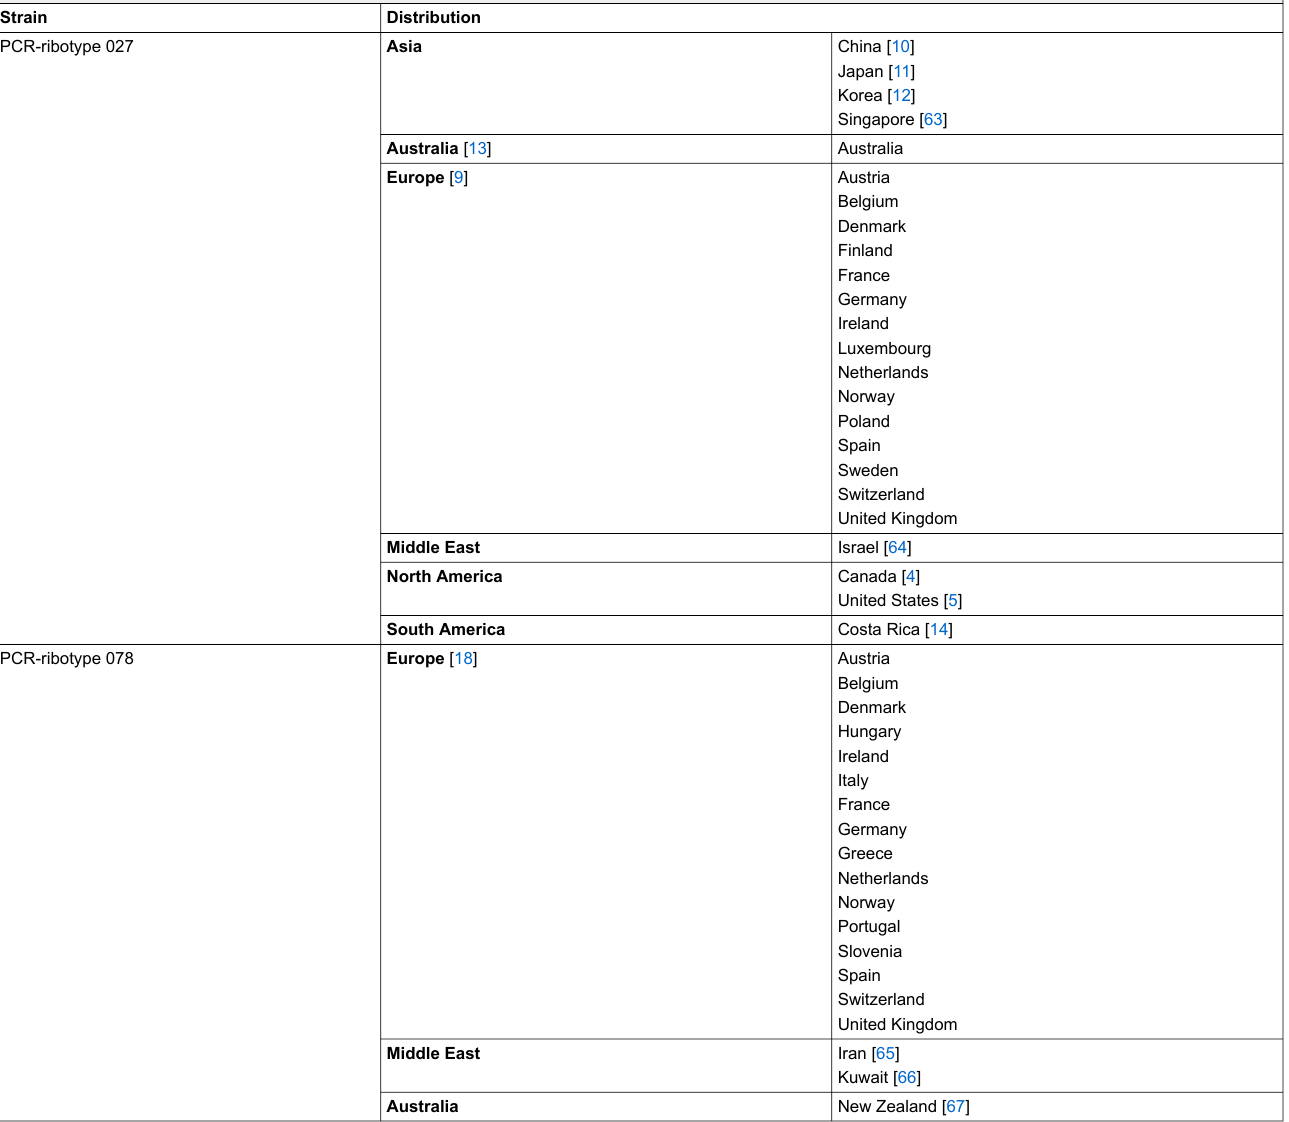
Table 1: Global distribution of the hyper-virulent Clostridium difficile ribotypes 027 and 078.